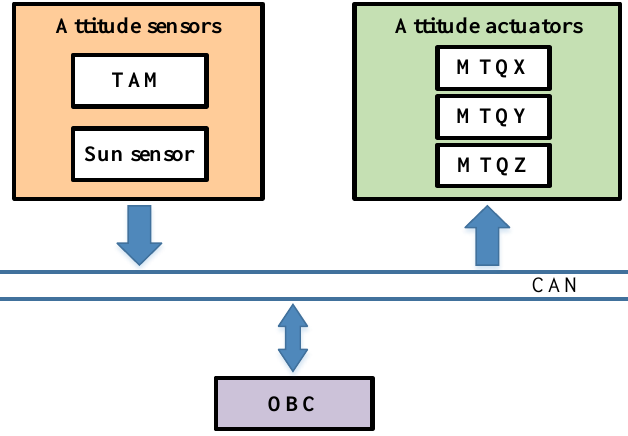
Figure 1. Structure diagram of considered ADCS.